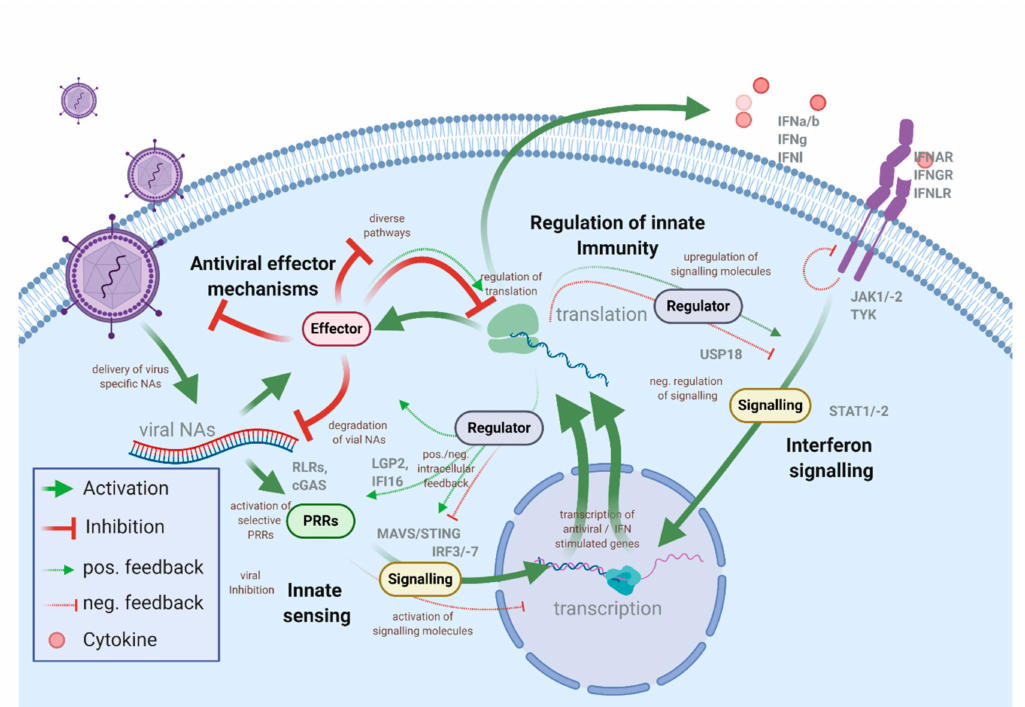
Figure 1. The antiviral innate immune response is orchestrated by signaling cascades and the synergistic activity of numerous factors that are converging in a complex regulatory network. Pathogen-associated molecular patterns such as viral nucleic acids (viral NAs) are sensed by cytoplasmic pattern recognition receptors (PRRs), which in turn, activate signaling cascades of the innate immune system. This leads to the expression of regulatory function (Regulator) and proteins with antiviral e ff ector proteins (E ff ector), which is controlled on transcriptional and translational level. Paracrine and autocrine interferon (IFN) signaling synergistically modulate these signaling cascades. The activity of numerous contributing factors puts the cell into an antiviral state, inhibiting virus replication at multiple stages of the viral life cycle. To avoid overshooting immune reactions and adverse e ff ects on cellular fitness, negative regulators eventually shut down the IFN